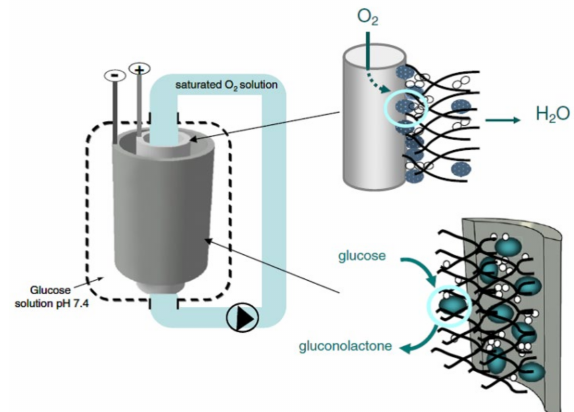
Figure 13. Schematic layout of the concentric glucose/O 2 biofuel cell. Reprinted from [21], with permission from